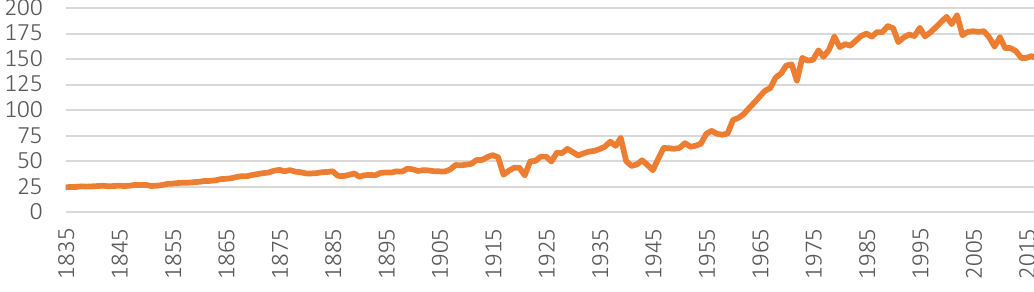
Figure 3b. Energy consumption per capita in billion Gigajoule derived units Figure 3. Energy intensity and consumption,